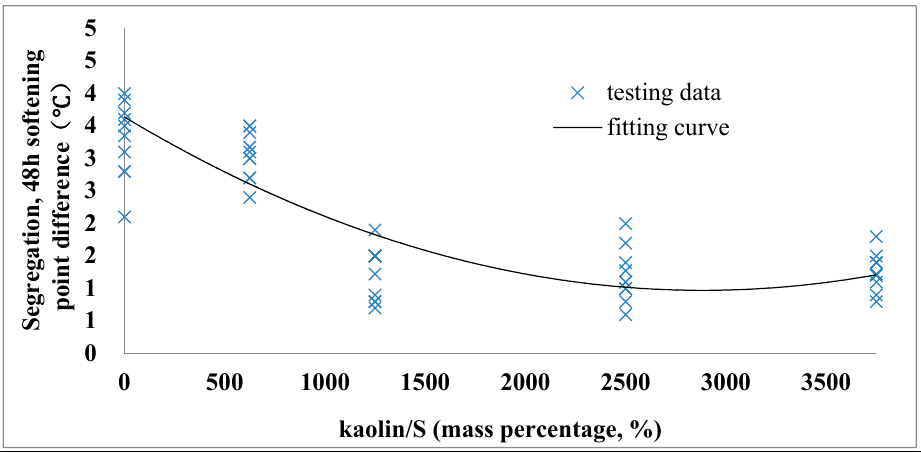
Figure 9. The relationship between kaolin content and the 48-h segregation softening point difference of SBS-modified bitumen.